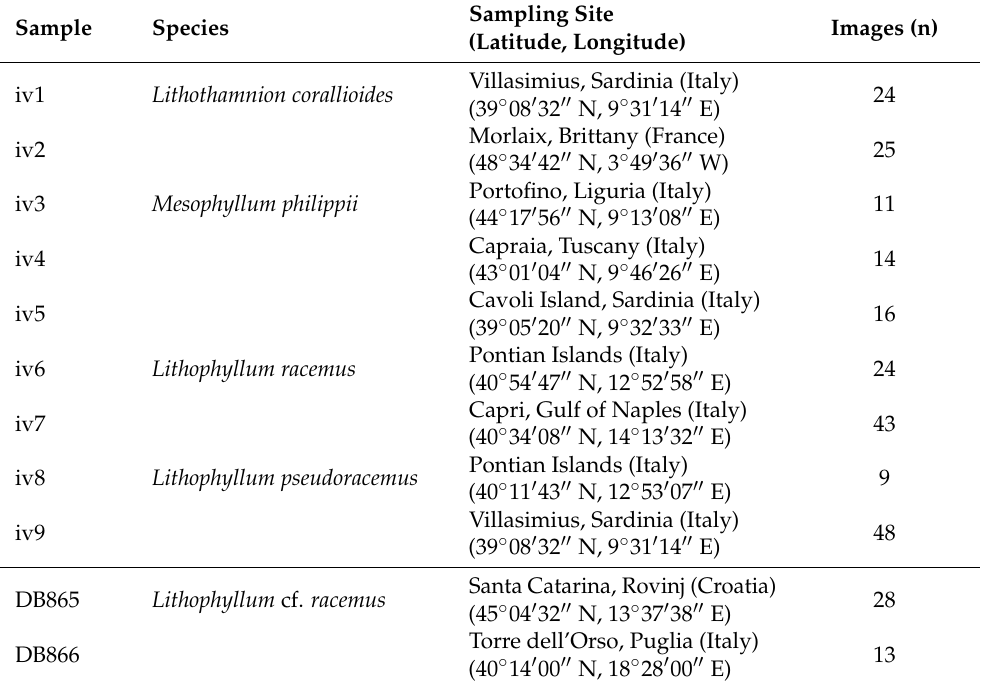
Table 1. Summary of the samples used, site of collection, and the number of SEM images per